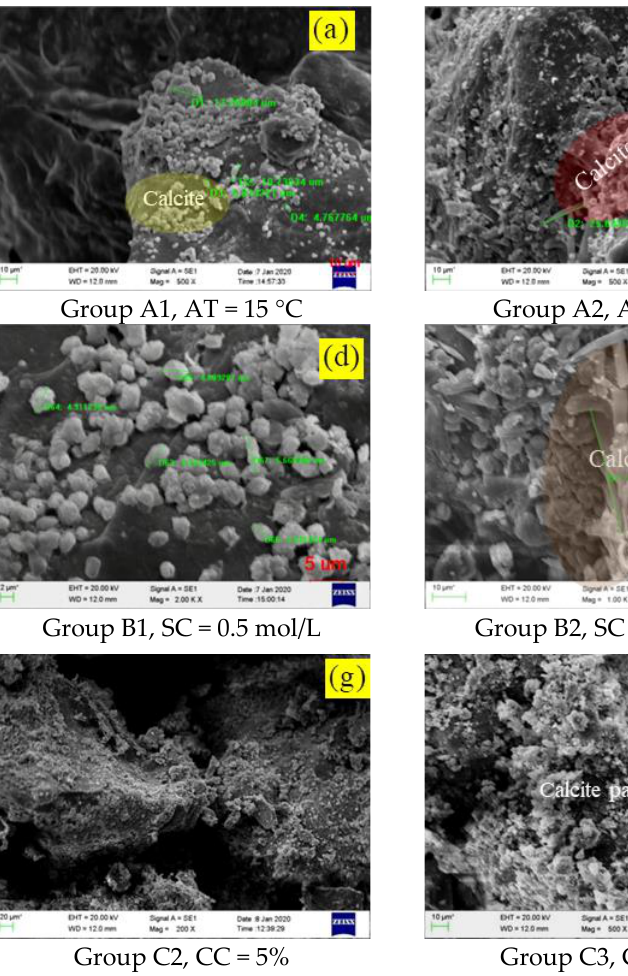
3 under different